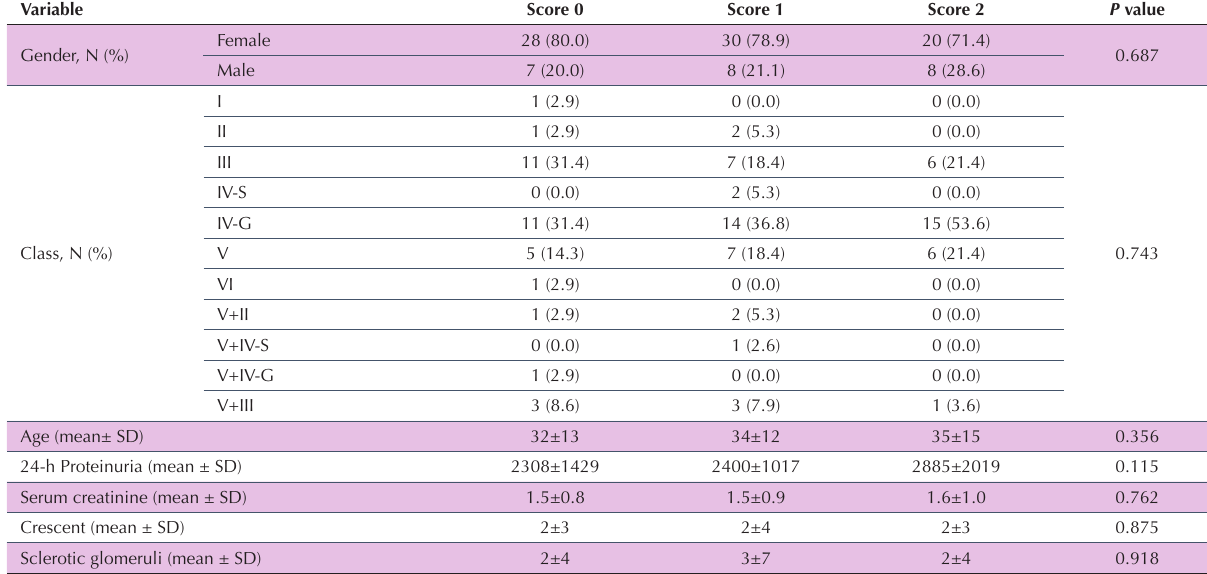
Serum creatinine (mean ± SD)